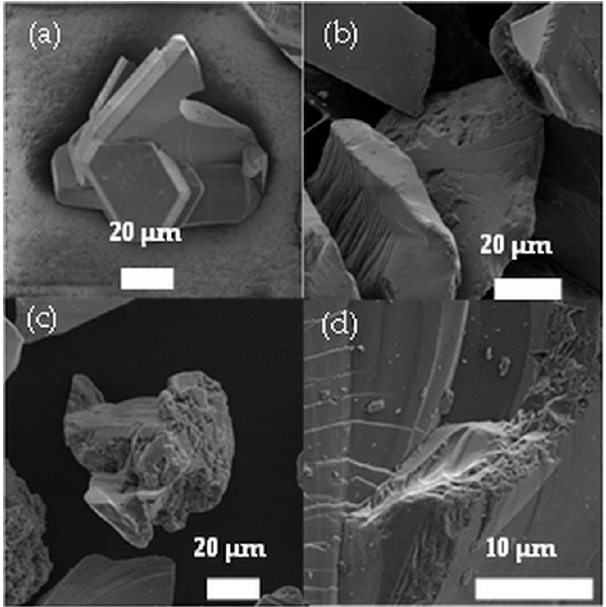
Figure 1. (a) Untreated 6H–SiC sample, (b) etched, (c) etched and sonicated, (d) double-etched sample .